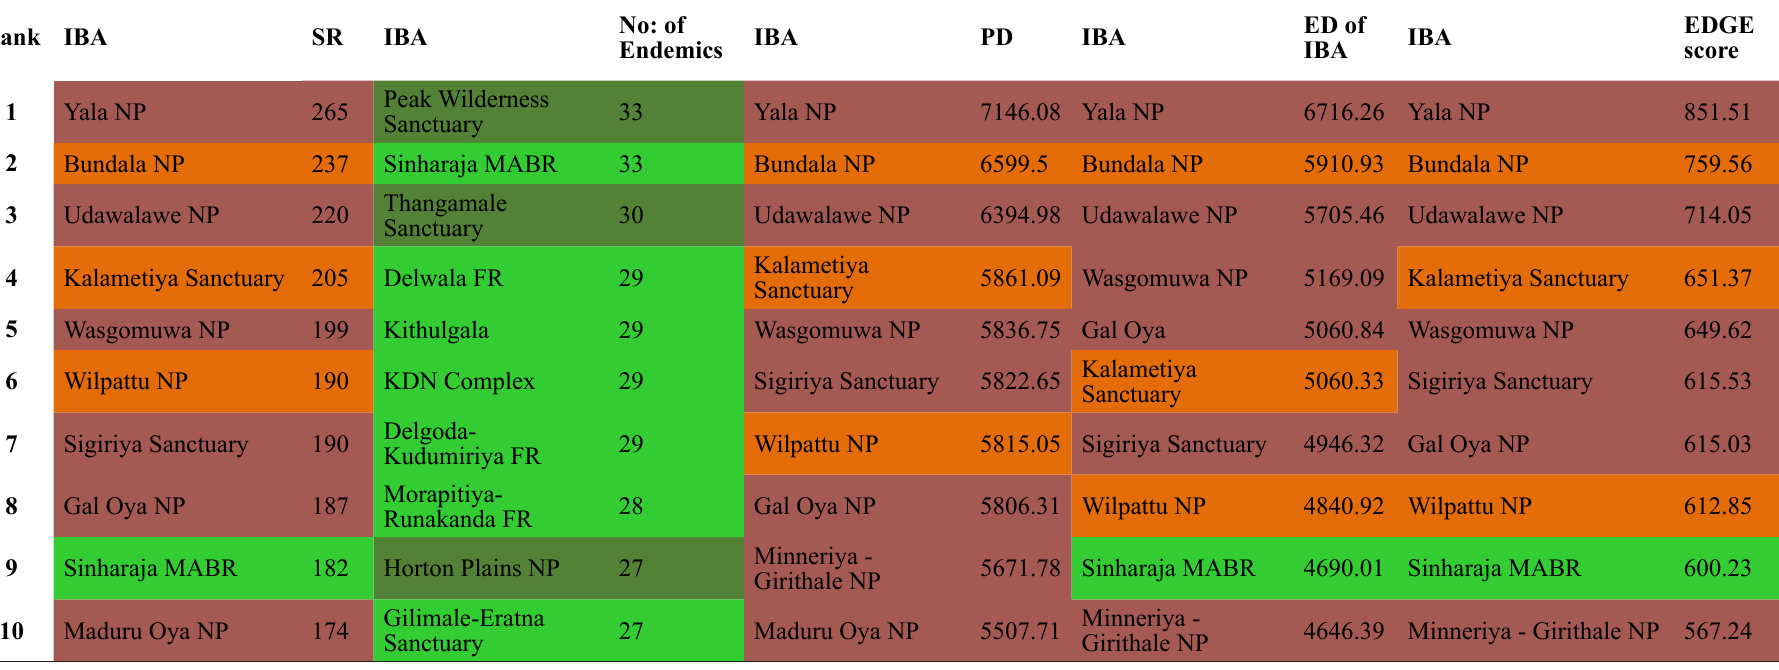
Table 05: IBAs with highest scores in SR, EM, PD, ED and EDGE scores with respect to the climatic zone. Both resident and migratory species are included in the analysis. Colour key: Tangerine-